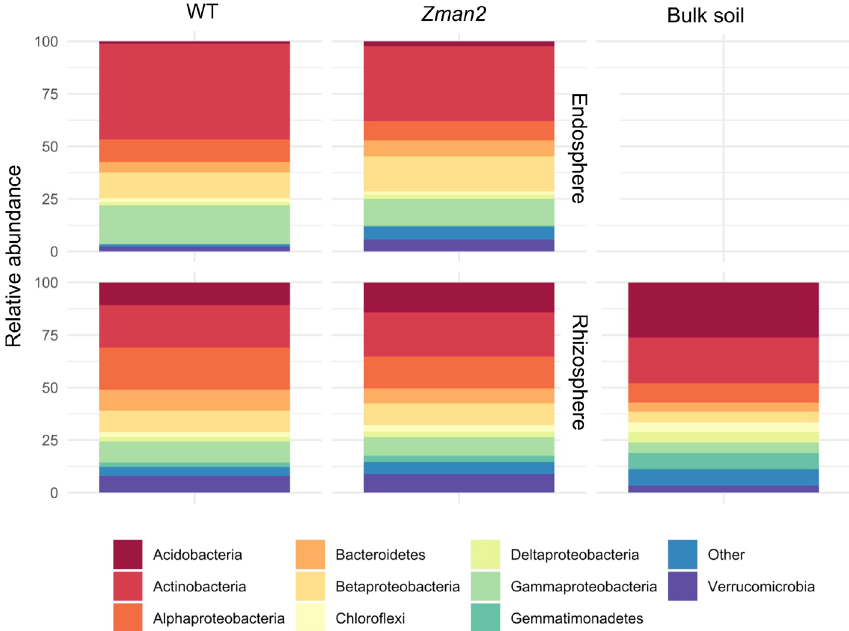
Figure 5. Distribution of the ten most abundant phyla for each sample type. Bars represent the relative abundance of all OTUs within each of the top 10 most abundant phyla. n = 5 (bulk soil) or n = 6 (all plant samples).